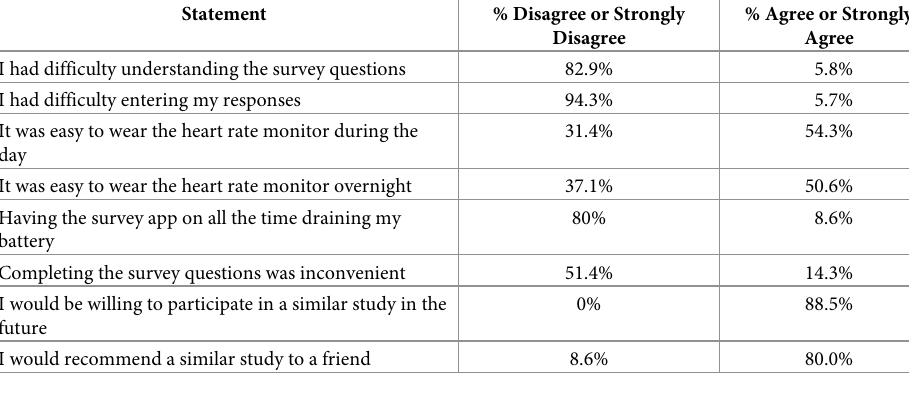
Table 2. Participant-reported study acceptability a .